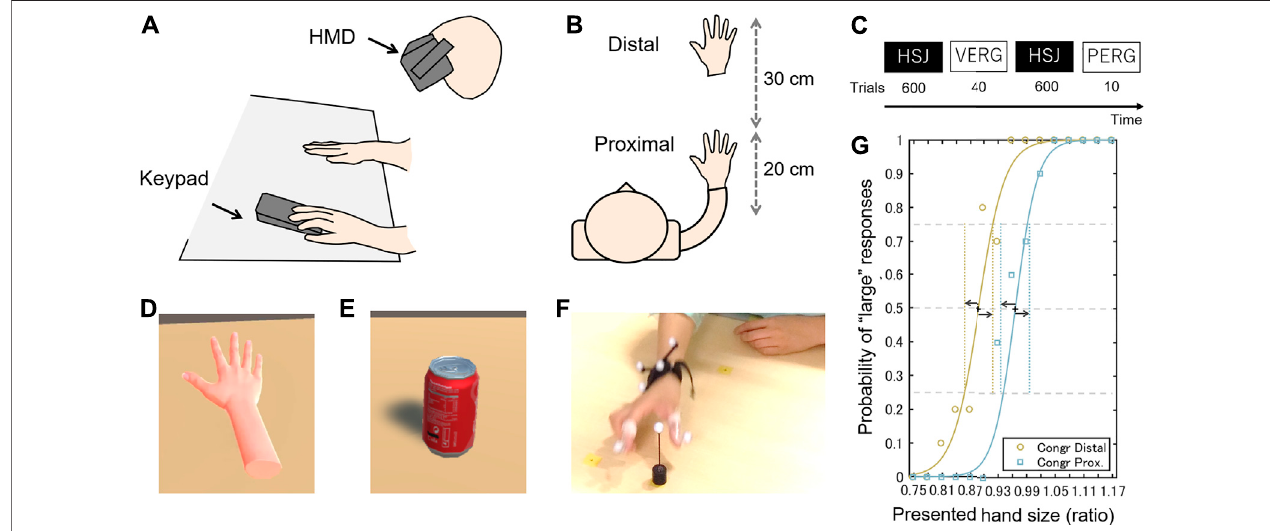
FIGURE 1 | Experimental settings and stimuli. Side and top (A, B) view of the experimental scene, the time course of the main experiment (C) , virtual hand presented in the main experiment (D) , virtual can presented in the reference experiment (E) , experimental scene of the reach-to-grasp movement task (F) , and an exampleofpsychophysicalfunctionsforthesizejudgmenttask (G) .Inpanel (G) ,thecrosses(+)indicateaPSE(50%probabilityofsmall/largeresponses)andthearrows indicate JND. HSJ: hand size judgment task, VERG: reach-to-grasp movement task in a virtual environment, PERG: reach-to-grasp movement task in a real